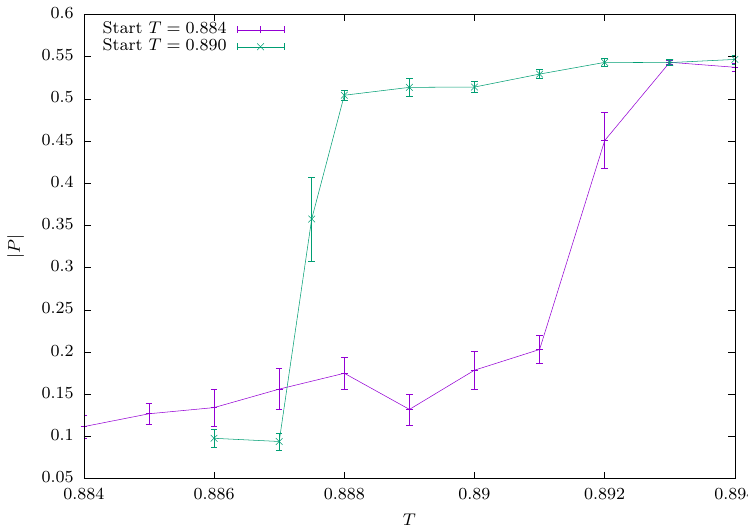
Figure 6. Hysteresis cycle for the order parameter j P j with N = 64, L = 32 in the D = 10 theory.